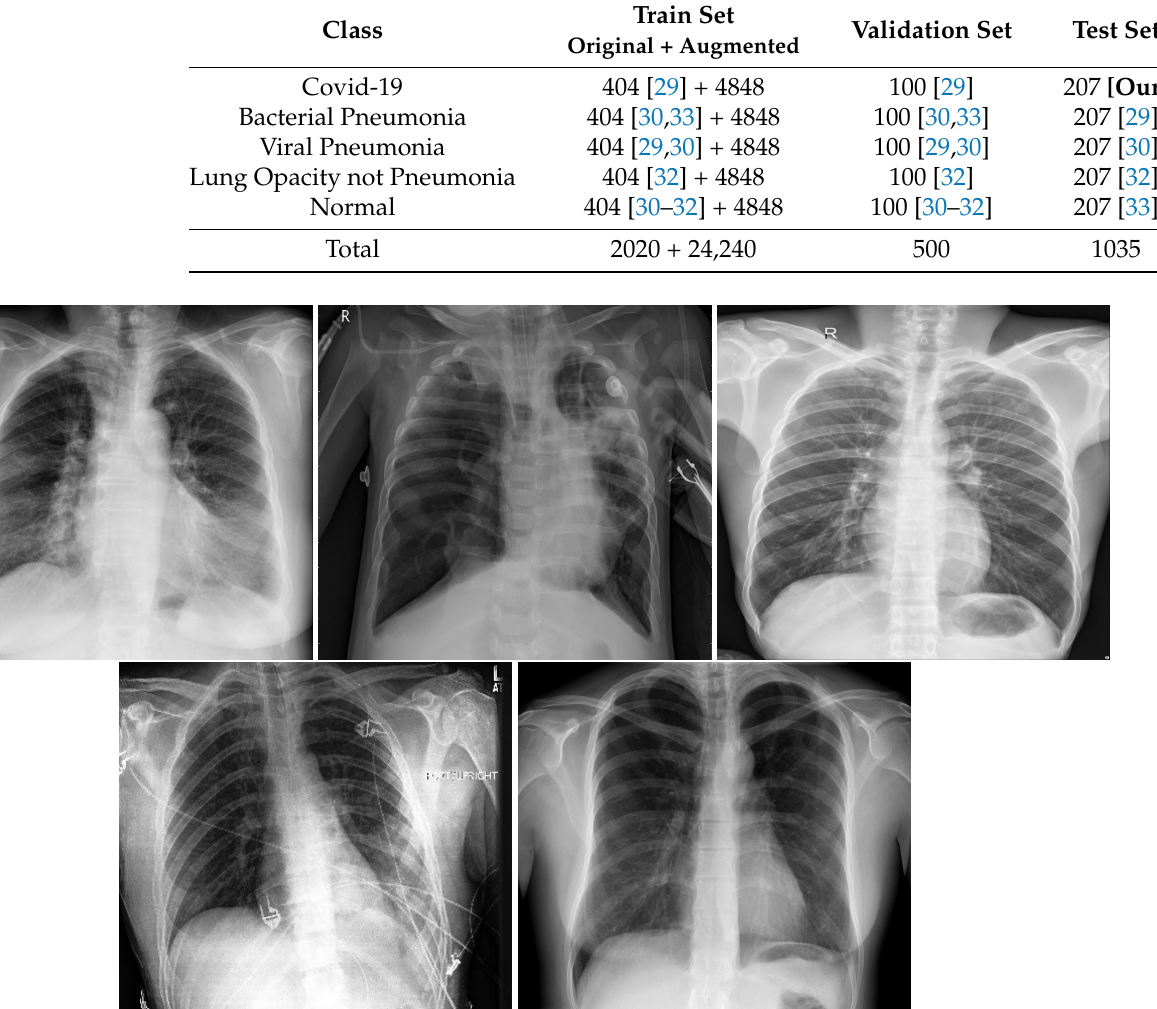
Table 3. Five-Class COVID-19 database sources and statistics.